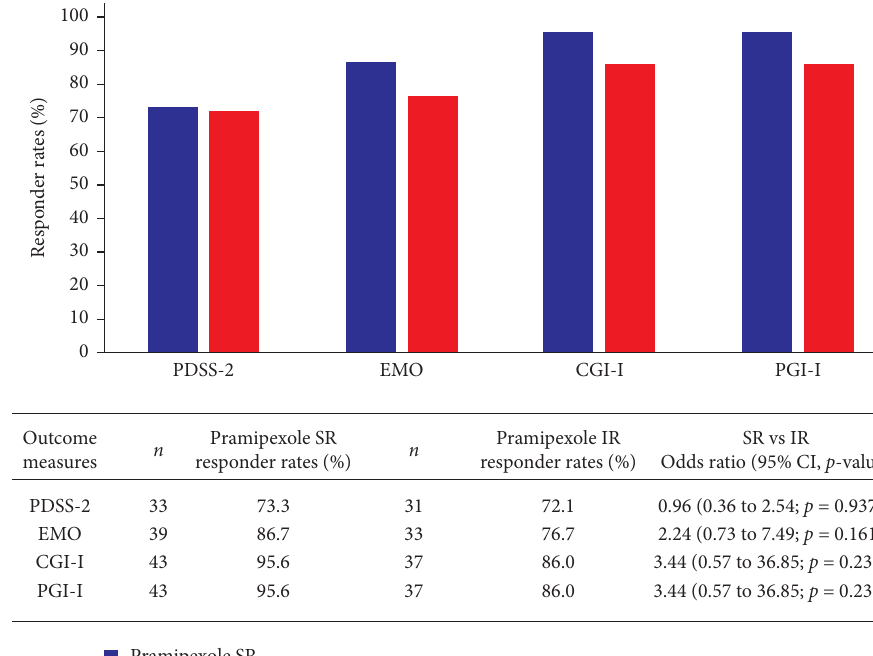
Figure 3: Responder rates in patients (FAS). The responder rates for each outcome measure: PDSS-2, total score < 18; EMO, patient improved at least 1 comparing to his/her baseline condition; CGI-I, clinician rated of any improvement (1 � very much better, 2 � much better, or 3 � a little better); PGI-I, patient rated of any improvement (1 � very much better, 2 � much better, or 3 � a little better). CGI-I,